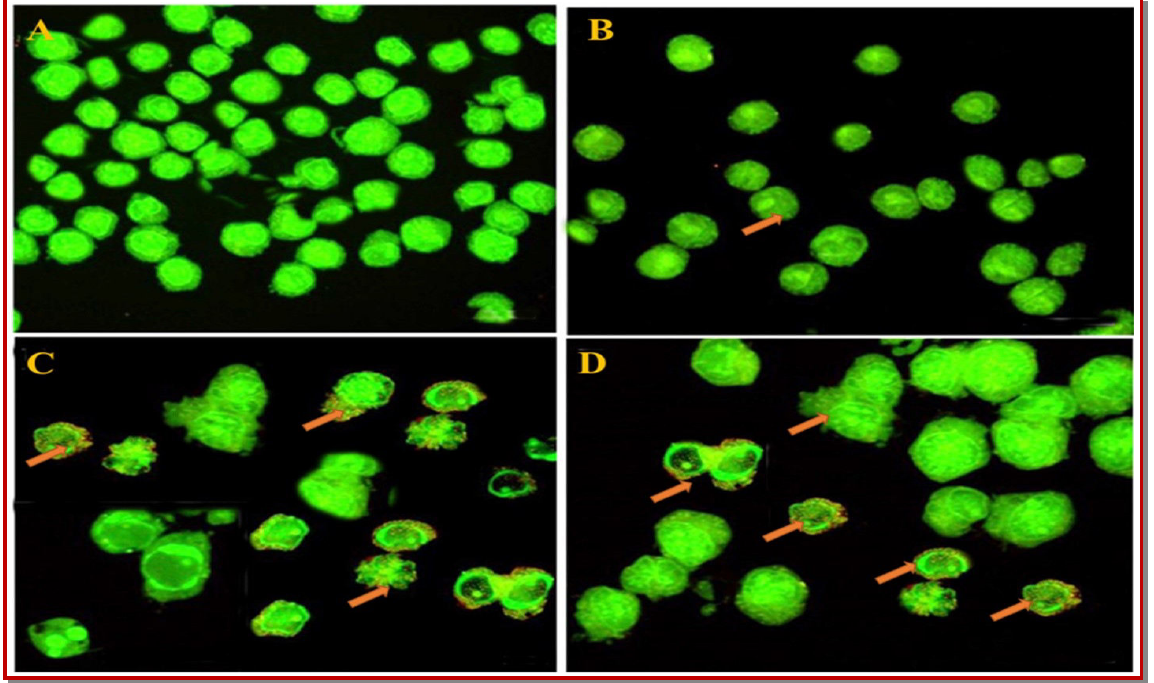
Figure 3: Fluorescent micrographs of acridine orange and propidium iodide double-stained A-549 cells. Intact green nuclei ap- pear in control (A) conditions suggesting a good cell viability. After exposure to different doses of theaflavin-3-Gallate, apoptot- ic cells appear. A, shows control cells with normal cellular morphology. B, C and D represent cells treated with 20, 80 and 160 µM dose of